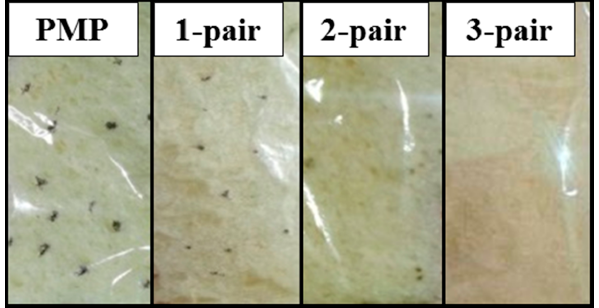
Figure 6. Images of food packed by PMP without and with different pairs of SiO x /SiC x H y stacked film. Table 1. Extent of fungi growth area ratio for food packed by PMP without and with different pairs of SiO x /SiC x H y stacked film.